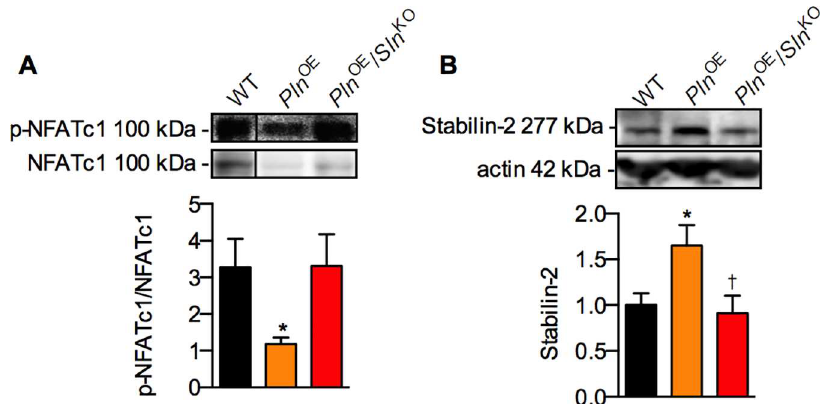
Fig 5. ElevatedNFATc1 phosphorylation status (A) and a failure to promote stabilin-2 expression(B) indicatesbluntedcalcineurin signalingin Pln OE / Sln KO mice. * Significantlydifferent from WT using a one-way ANOVA with a Games-Howellpost-hoc for unequalvariances(A, n = 7–12 per genotype), or a Tukey’s post- hoc test (B, n = 9–10 per genotype); † significantly different from Pln OE , p (cid:20) 0.05. All values are means ± SEM.